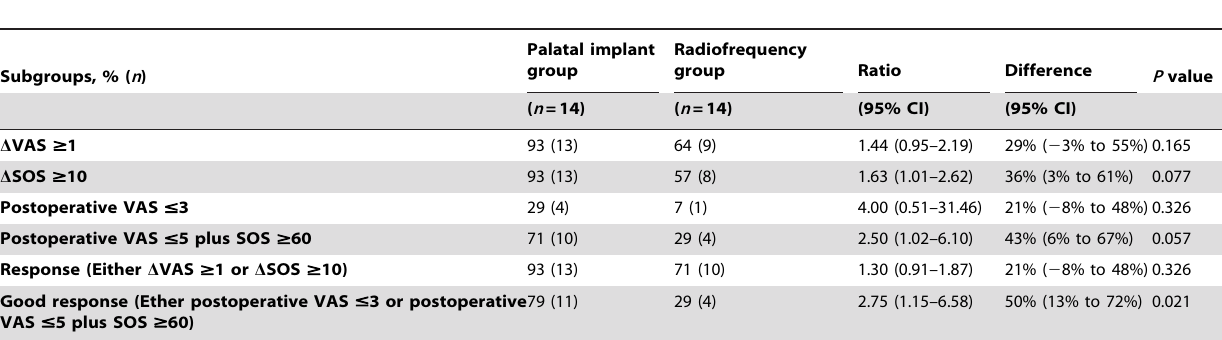
Table 2. Comparison of the postoperative changes in subjective questionnaire scores between the palatal implant and radiofrequency surgery